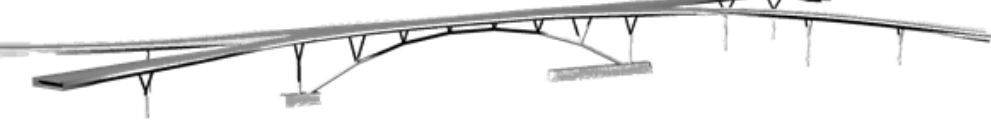
Figure 10. Perspective rendering of the 3D model for Streicker Bridge.